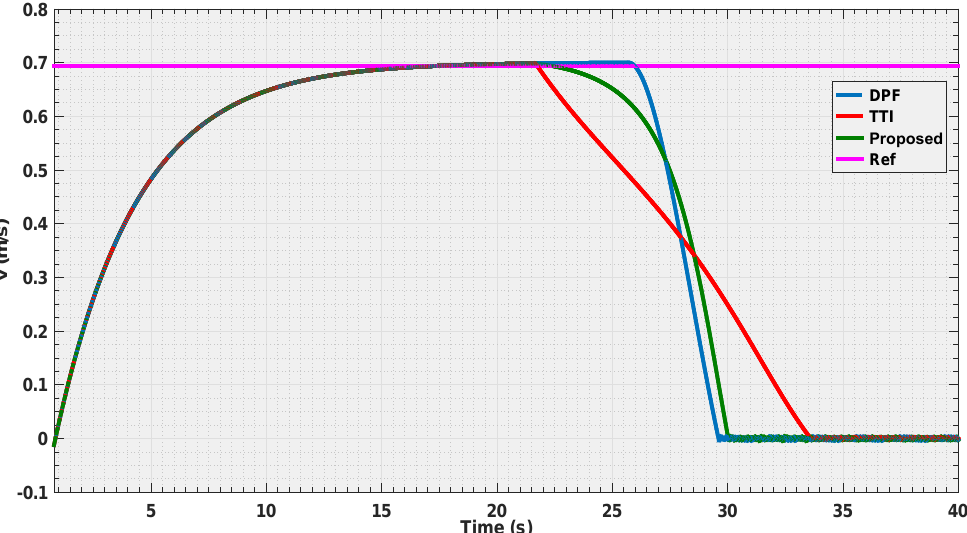
Figure 13. Velocity estimation by the three evaluated algorithms Experiment 1 .